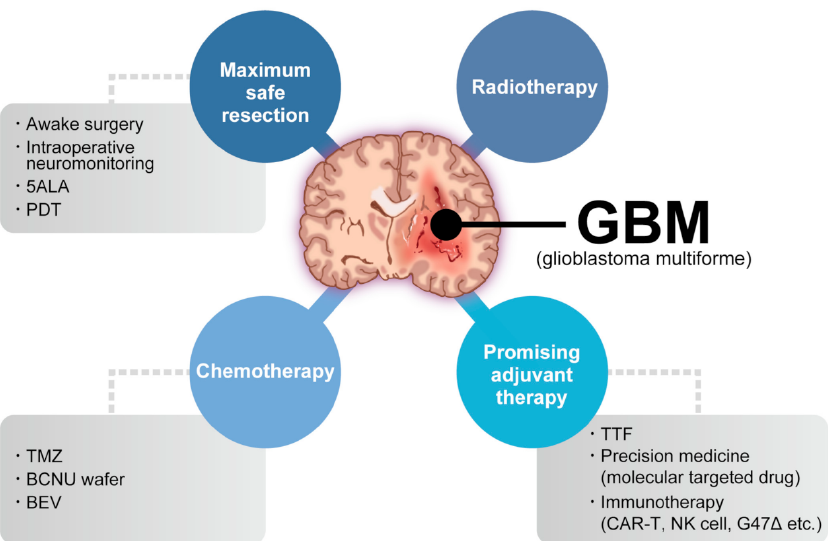
Figure 1. Multimodality treatment against GBM. While the standard therapy consists of maximum safety resection, adjuvant radiotherapy, and chemotherapy with temozolomide, which is collec- tively termed the Stupp regimen, several promising adjuvant therapies have been used for treating GBM. 5ALA: aminolevulinic acid, PDT: photodynamic therapy, TTF: tumor-treating fields, TMZ: temozolomide, BCNU: carmustine, BEV: